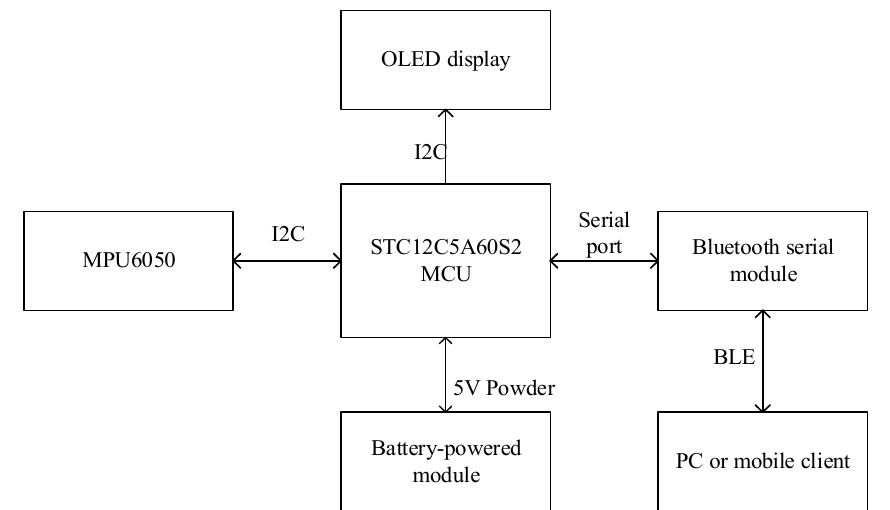
Figure 2. Hardware design diagram. Table 1. Some important parameter settings of the hardware platform.